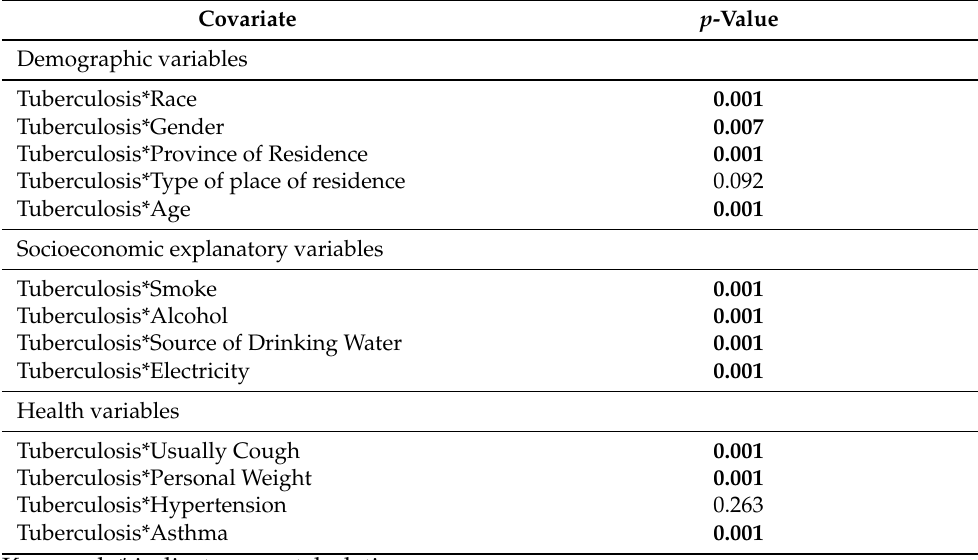
Table 2. Descriptive statistics for dependent and predictor